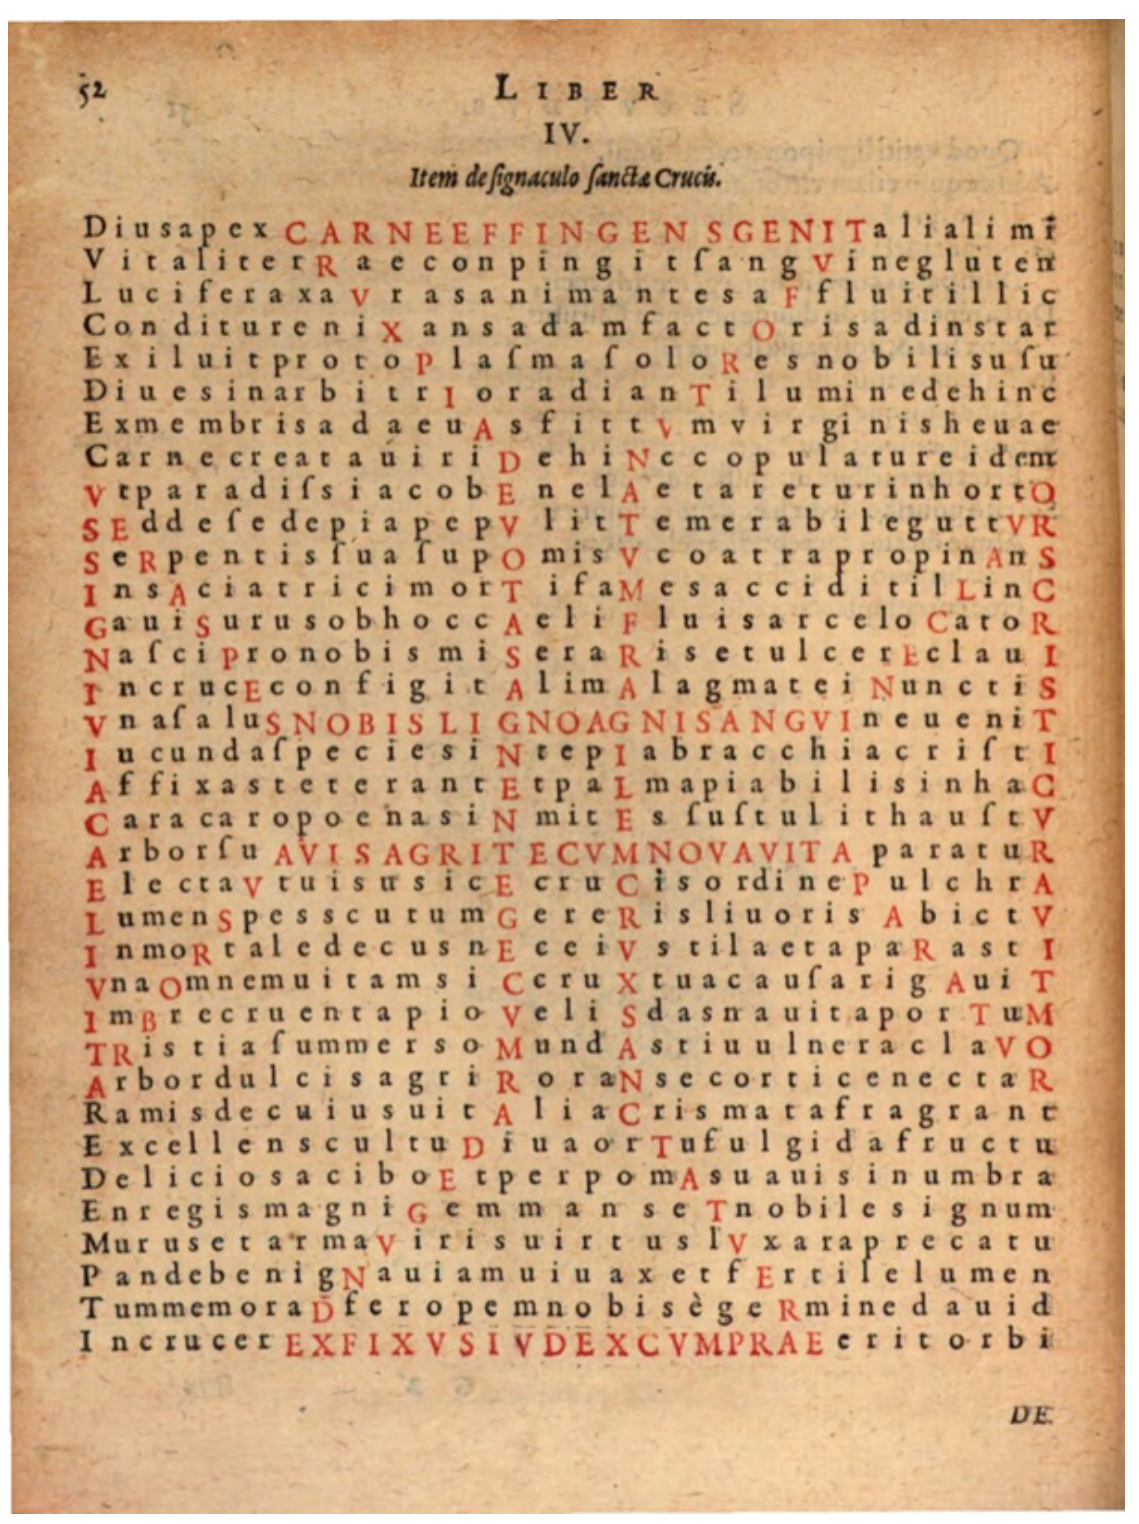
Figure 1 Bayerische Staatsbibliothek München, 4 P. lat. 426, S. 52,